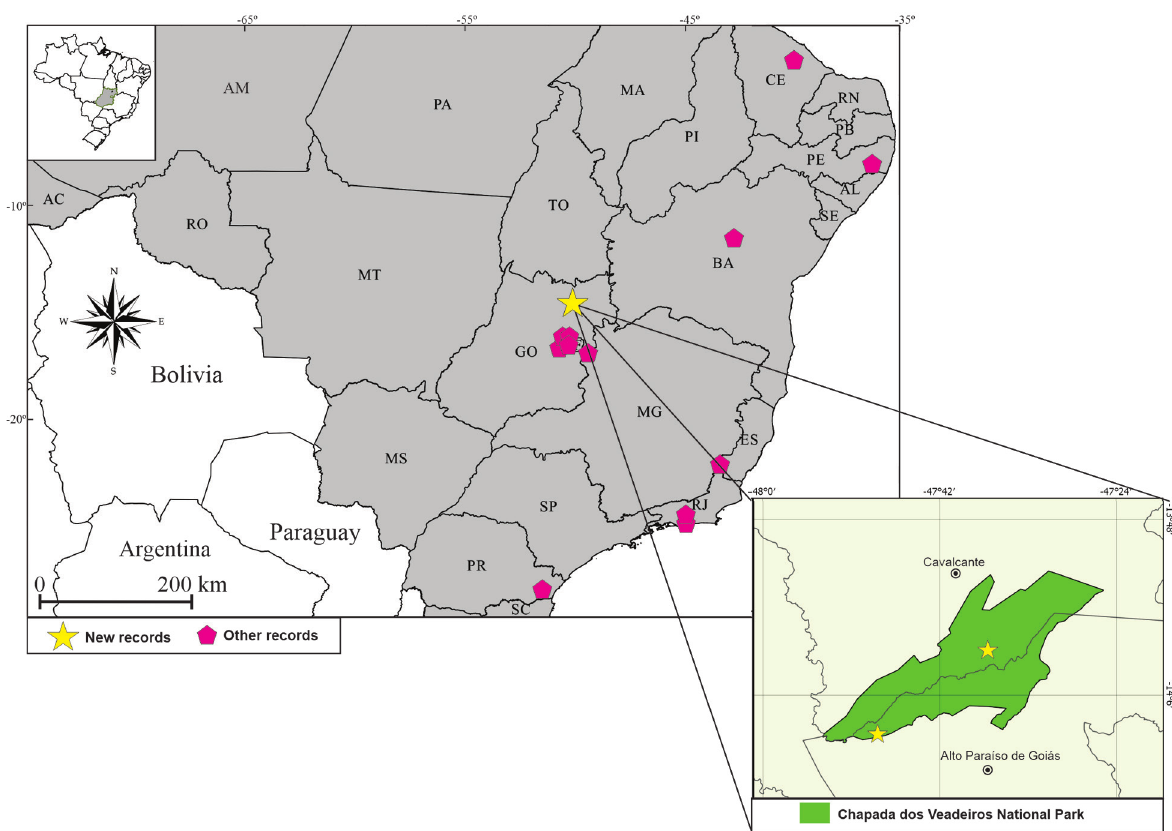
Figure 1. Geographic distribution of Scaphyglottis livida (Lindl.) Schltr. New records of S. livida in the Chapada dos Veadeiros National Park (Goiás). BA = Bahia. CE = Ceará. DF = Distrito Federal. ES = Espírito Santo. GO = Goiás. MT = Mato Grosso. MS = Mato Grosso do Sul. MG = Minas Gerais. PE = Pernambuco. PR = Paraná. RJ = Rio de Janeiro and TO =